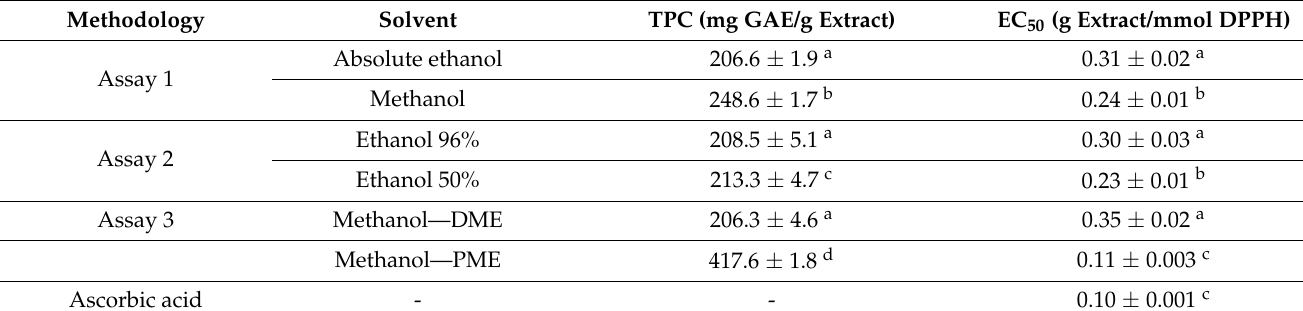
Table 1. Total phenol content (TPC) and antiradical test.